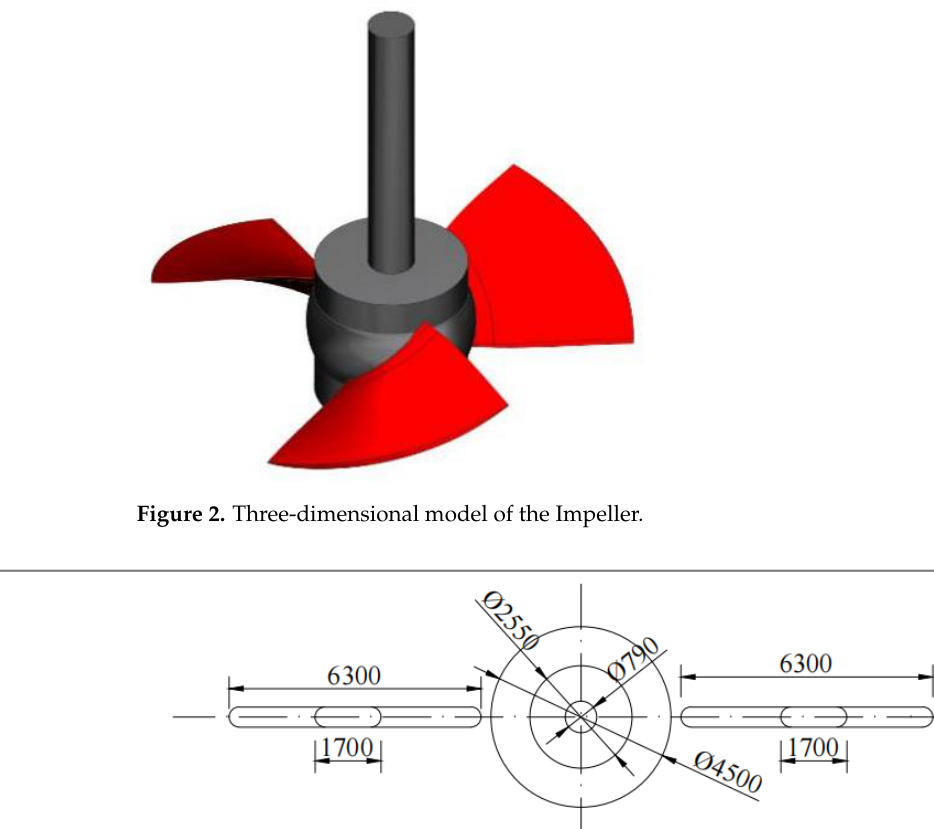
Figure 3. Top view of the full flow path of the pumping station.